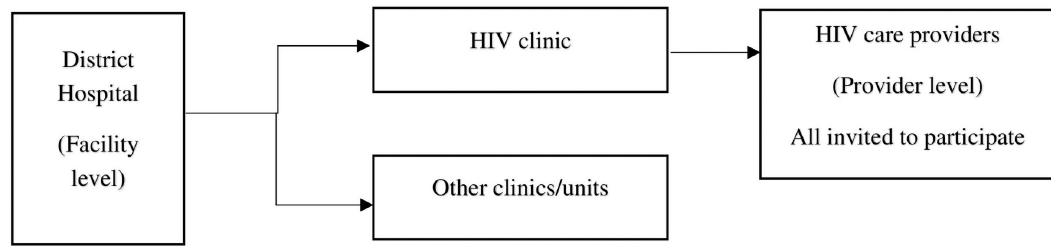
Fig 3. A typical structure of district hospital depicting where facility and provider levels